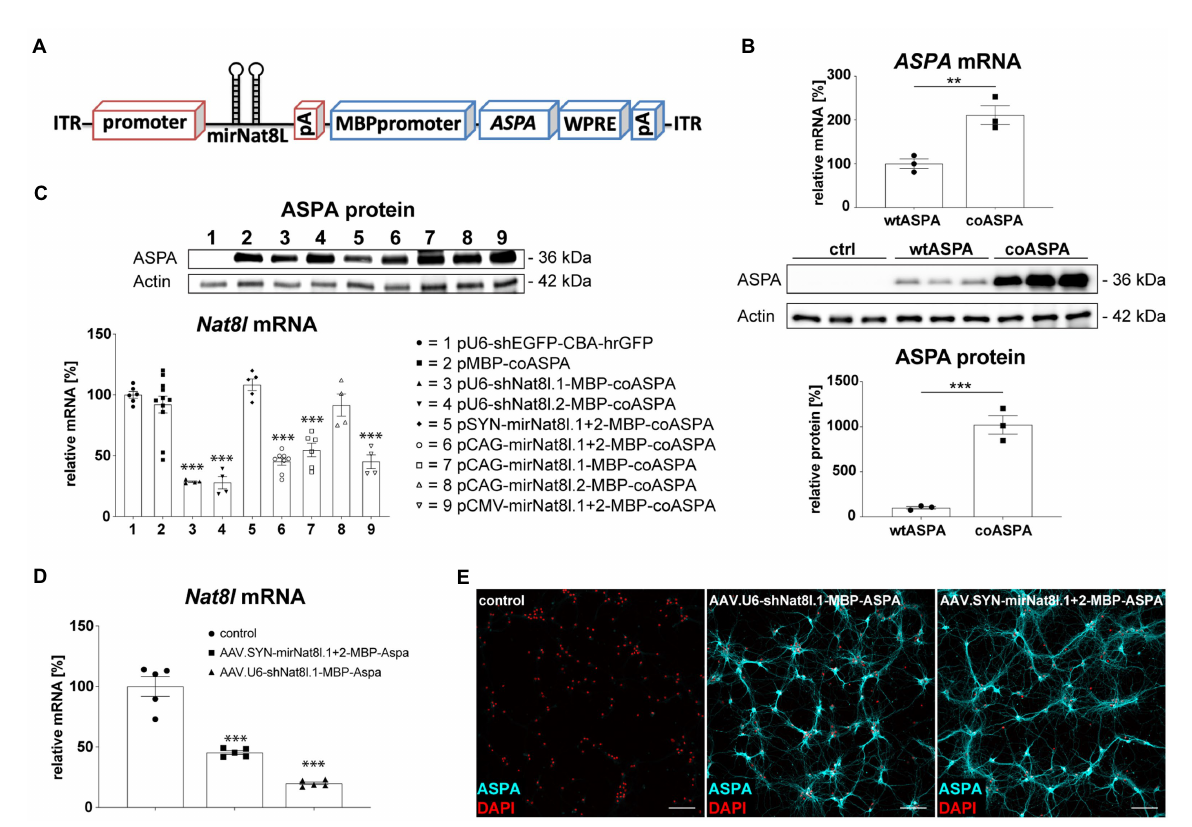
FIGURE 1 Vector design and in vitro biopotency of dual-function AAV vectors. (A) Design of dual-function AAV expression cassette. (B) Codon-optimization increases ASPA expression. HEK293 cells were transfected with equimolar amounts of wildtype ASPA (wtASPA) and codon-optimized ASPA ( coASPA ). (B, top) ASPA mRNA levels were determined by qPCR. ΔΔ Ct values normalized to the housekeeper Gapdh are displayed ( n = 3). (B, bottom) Western blot depicting ectopic ASPA expression 3 days post transfection and densitometric quantification of ASPA normalized to